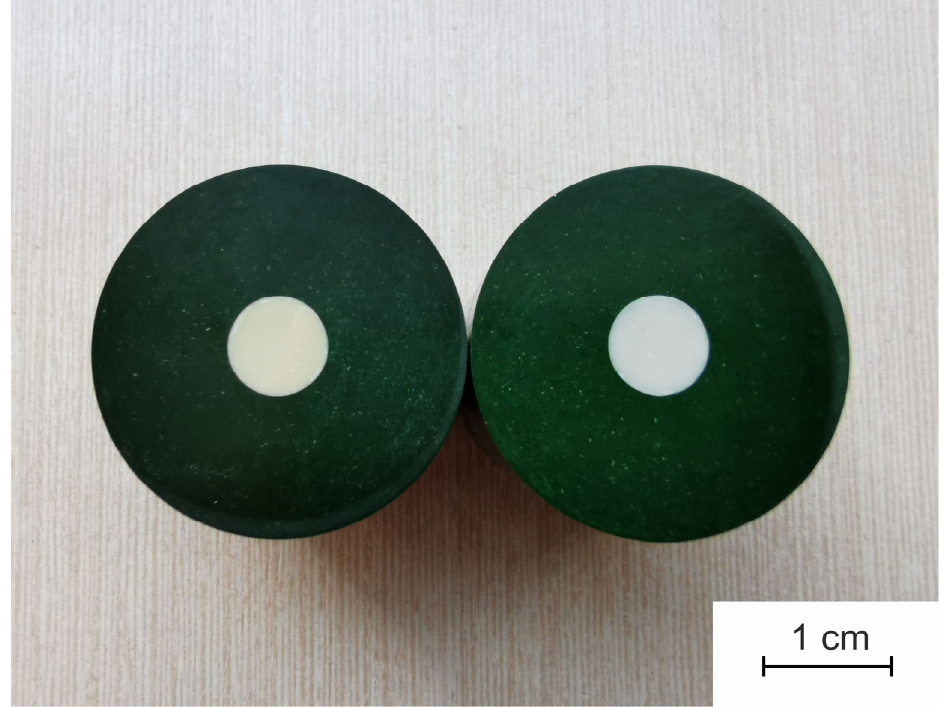
Figure 5. The photo of 2-wt% CaO-ZrO 2 ceramics made of the baddeleyite concentrate ( left ) and chemically synthesized monoclinic zirconia ( right ). The samples are prepared for mechanical tests.